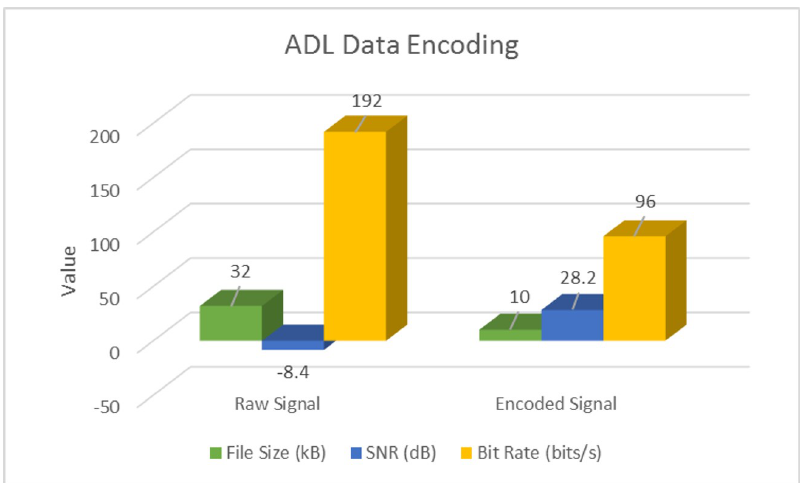
Figure 8. Encoding ADL actigraphy signals.